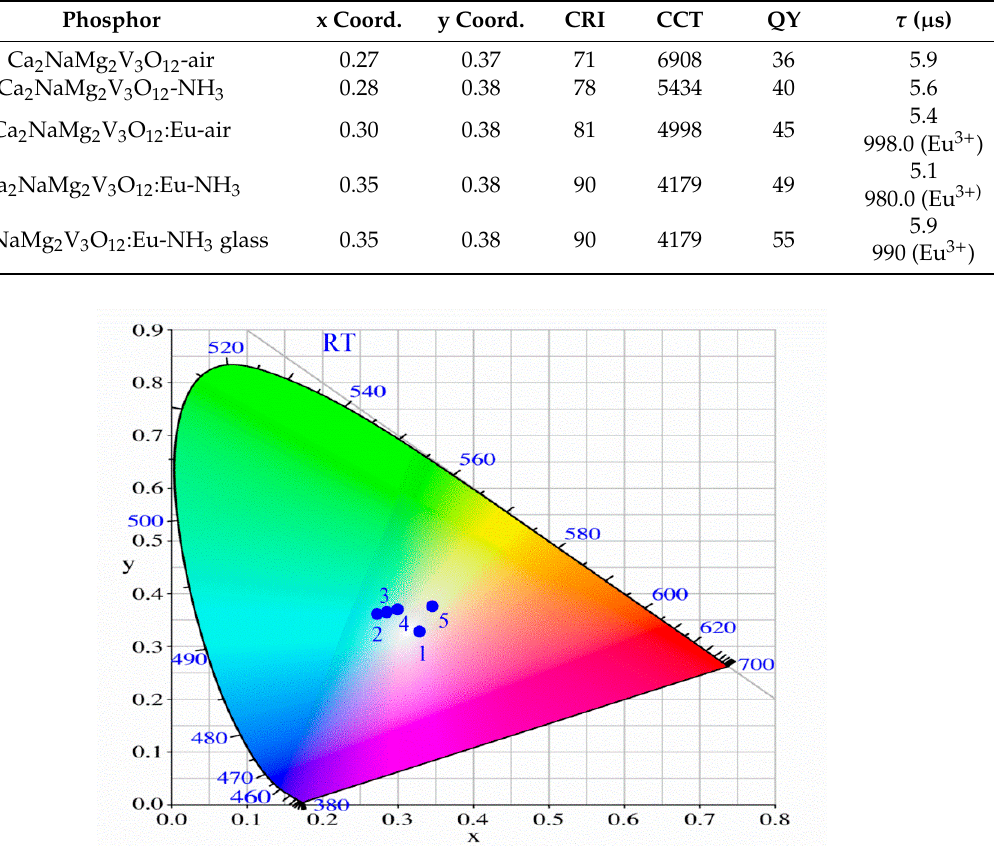
Table 1. Color coordinates (x, y), color rendering index (CRI), correlated color temperature (CCT), quantum yield (QY), and decay times τ ( µ s) for Ca 2 NaMg 2 V 3 O 12 and Ca 2 NaMg 2 V 3 O 12 : Eu samples obtained at di ff erent conditions. λ exc = 335 nm.